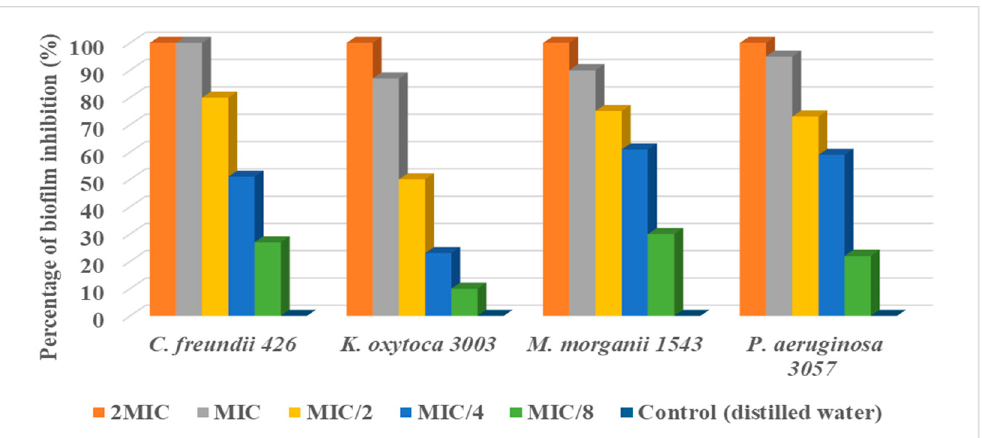
Figure 3. Antibiofilm activity of A. vera extract against selected Gram-negative bacteria involved in urinary tract infections (UTIs).